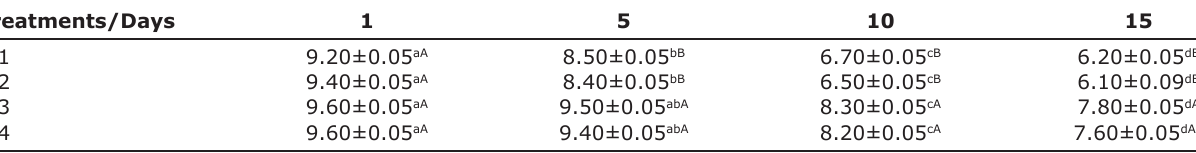
Table-4: Odor scores of Vawksa rep (smoked pork product) stored under vacuum packaging conditions at 4°C±1°C.